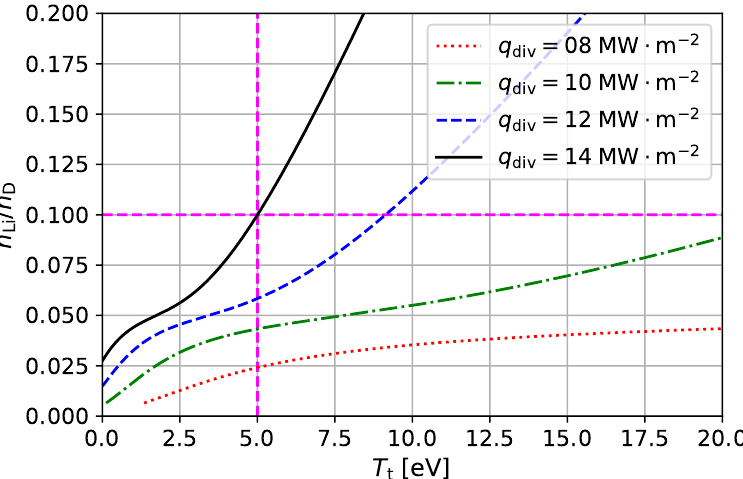
Figure 4. Relative lithium concentration in the divertor n Li / n D as a function of the plasma tempera- ture in front of the target T t for different values q div . The operational window of the radiating LL divertor is determined by the conditions: n Li / n D ≤ 0.1 and T t ≥ 5